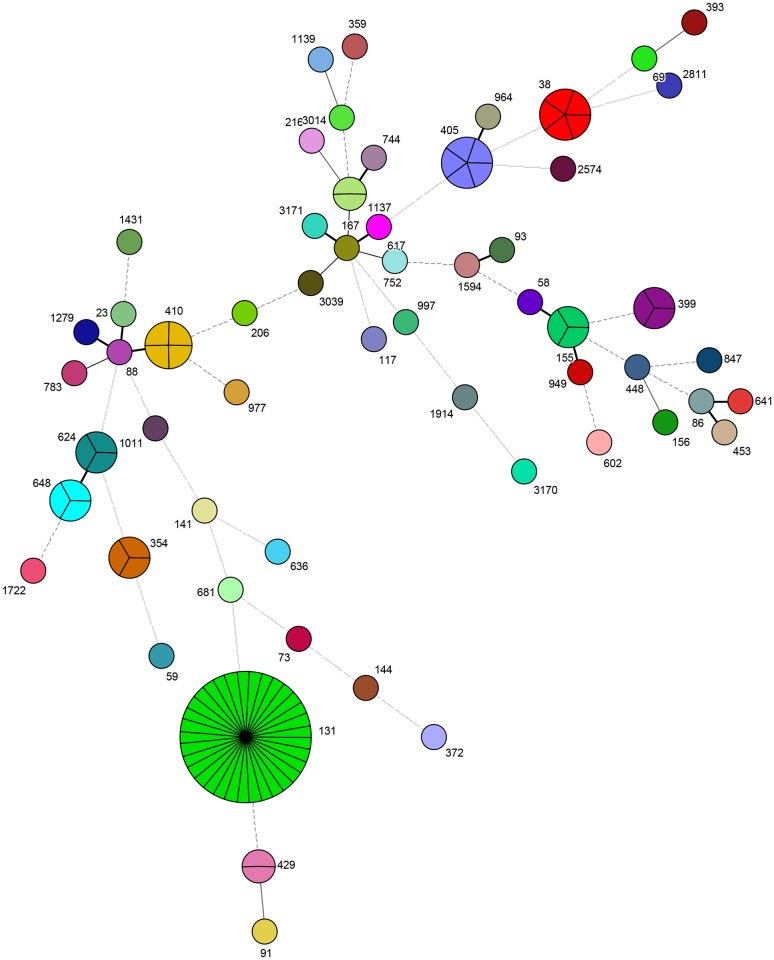
Representative genotypic ESBL-producing E. coli clusters observed using High-throughput multilocus sequence typing (HiMLST).The different colors represent different sequence types. 1 allele difference = thick solid line; 2 allele differences = medium solid line; 3 allele differences = thin solid line; 4 allele differences = dashed line; >4 allele differences = dotted line.